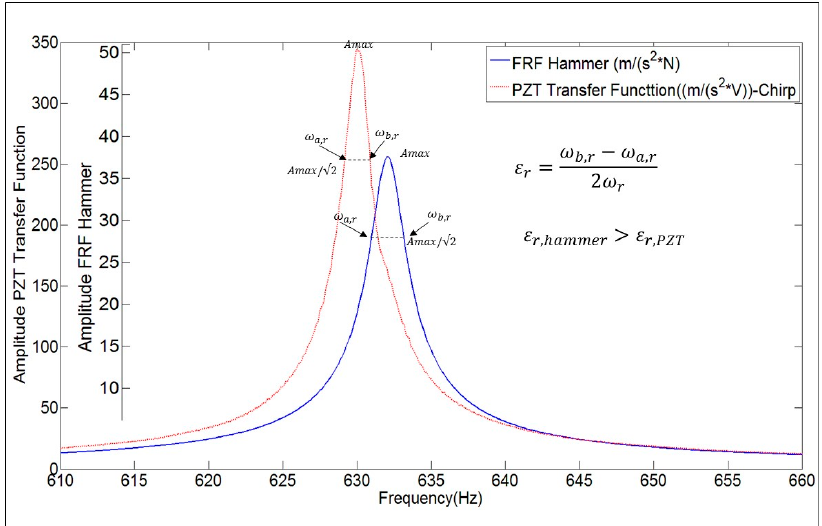
Figure 16. Natural Frequency and Damping estimation of the fourth mode of the disk submerged in water close to a rigid wall. water close to a rigid